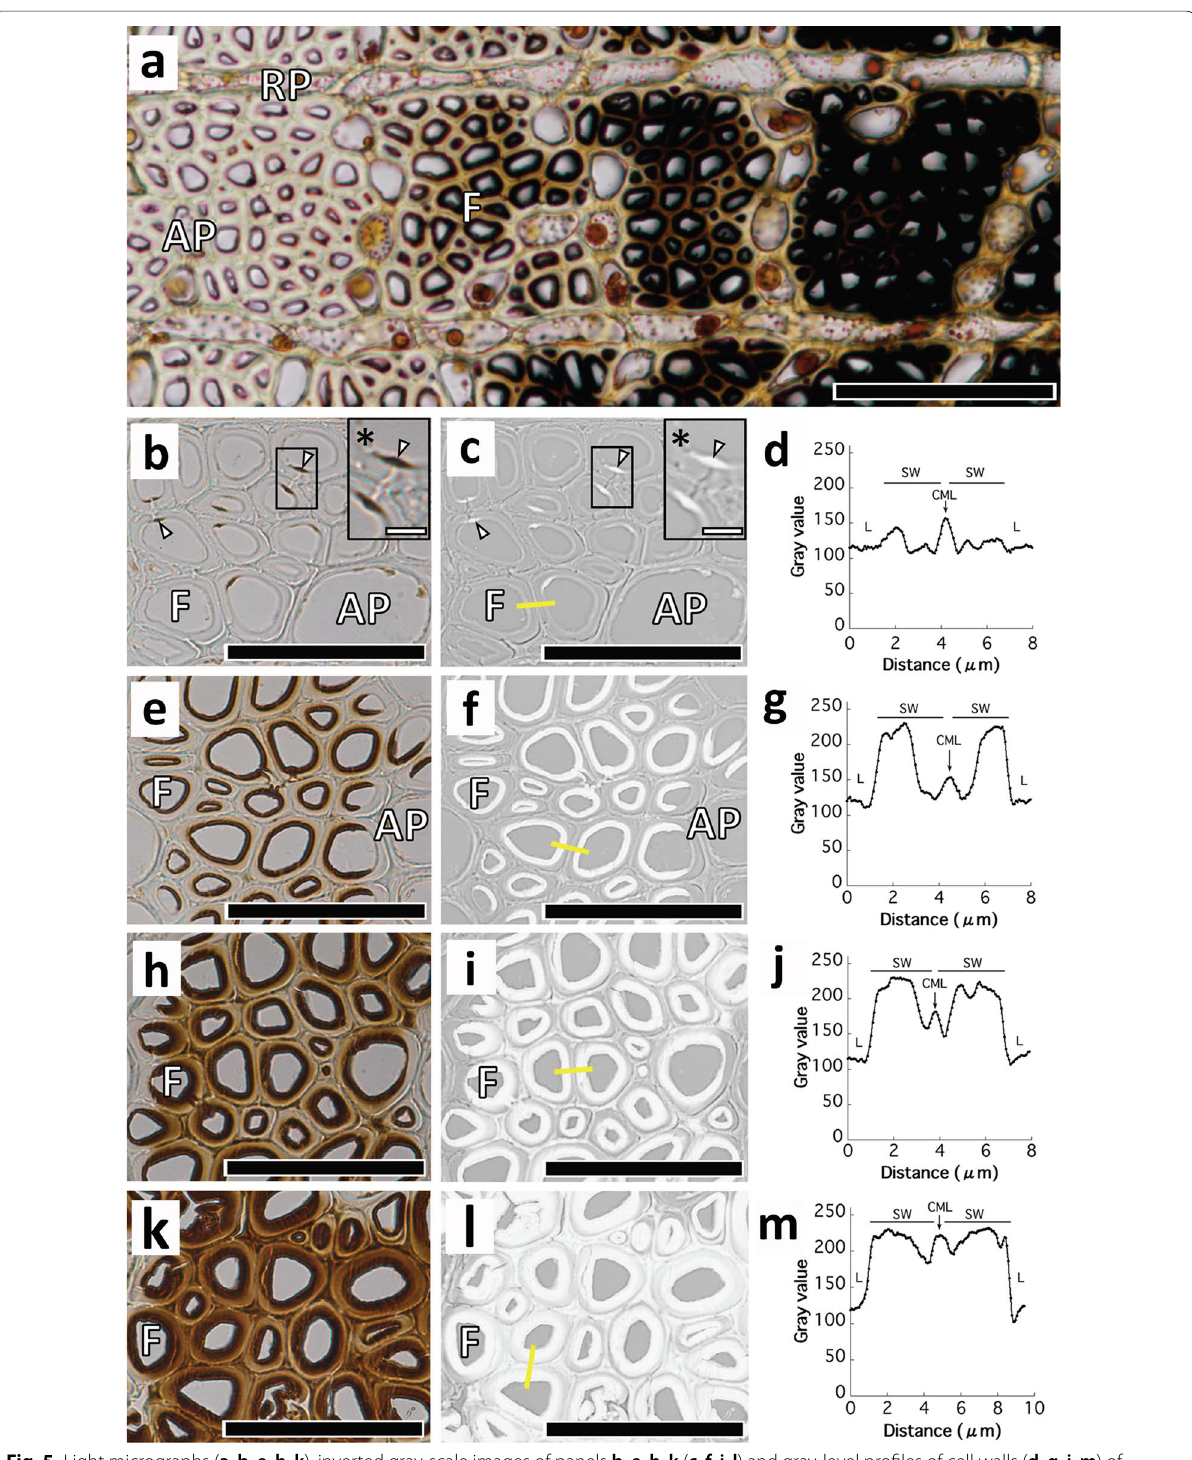
Fig. 5 Light micrographs ( a , b , e , h , k ), inverted gray-scale images of panels b , e , h , k ( c , f , i , l ) and gray-level profiles of cell walls ( d , g , j , m ) of transverse sections at the boundary between whitish and black regions in samples of D . kaki wood. Representative gray-level profiles in d , g , j , m were obtained from the yellow-lined sites in the gray-scale images c , f , i , l , respectively. Asterisks in b , c show higher-magnification images of a pit region (the enclosed area). White arrowheads indicate deposits of colored substances on the inner surfaces of wood fibers in pit regions. AP: axial parenchyma cell; CML: compound middle lamella; L: lumen; RP: ray parenchyma cell; SW: secondary wall; F: wood fiber. Scale bars 50 μm in b , c , e , f , h , i , k , l ; 5 μm in enclosed area of b ,